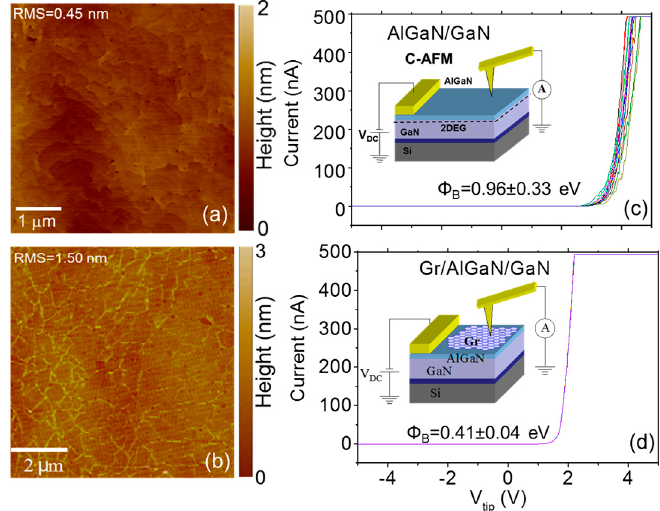
Figure 10. AFM morphologies of an AlGaN/GaN heterostructure ( a ) and of Gr transferred onto AlGaN/GaN ( b ). Current-voltage characteristics measured by conductive atomic force microscopy (CAFM) on an array of different positions on the bare AlGaN surface ( c ) and on the Gr-coated AlGaN surface ( d ). Figures adapted with permission from [100].